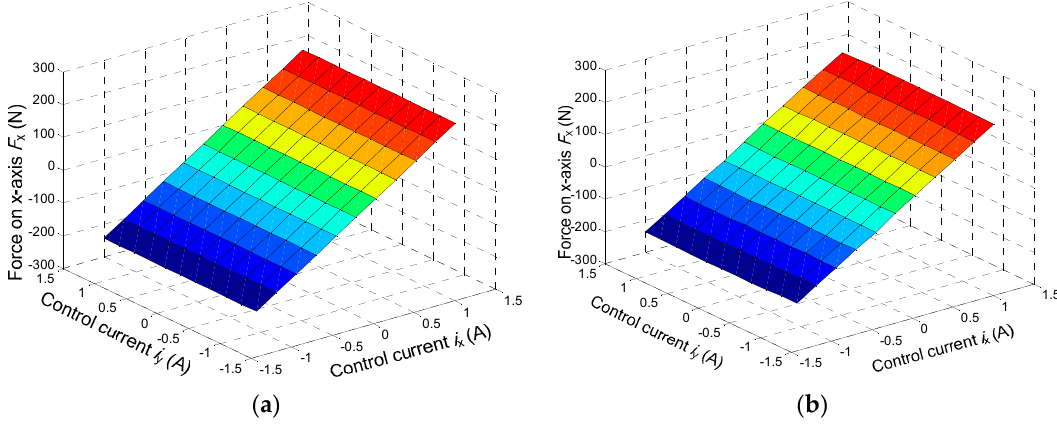
Figure 10. Curves of relationship between suspension force on x ‐ axis and radial control current. ( a ) Analytical results; ( b ) Finite element method (FEM) results.